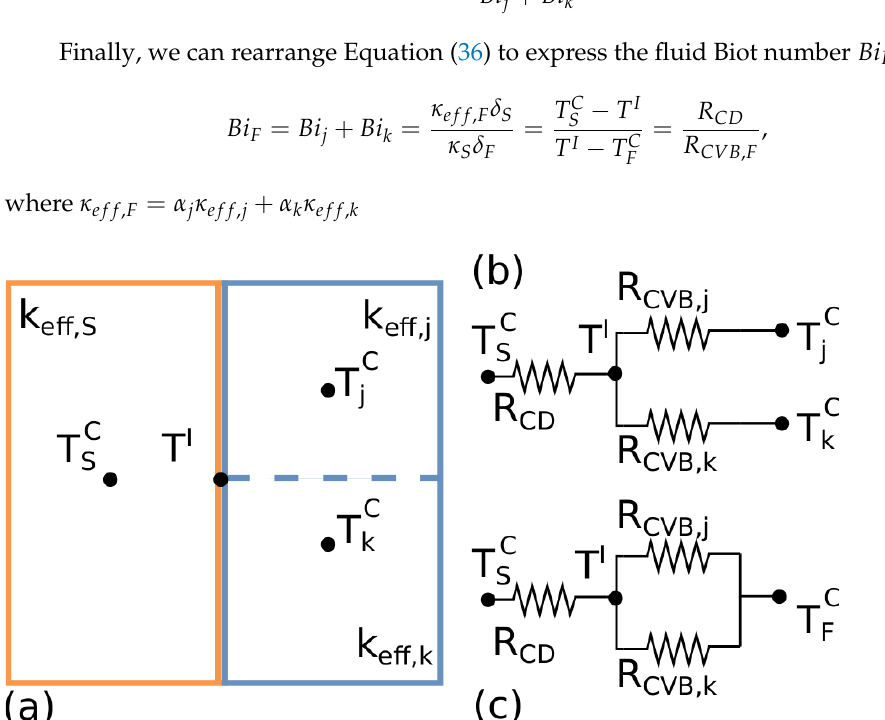
Figure 2. ( a ) Solid–fluid interface mesh view; ( b ) Partitioned heat transfer into liquid and vapour; ( c ) Heat transfer into